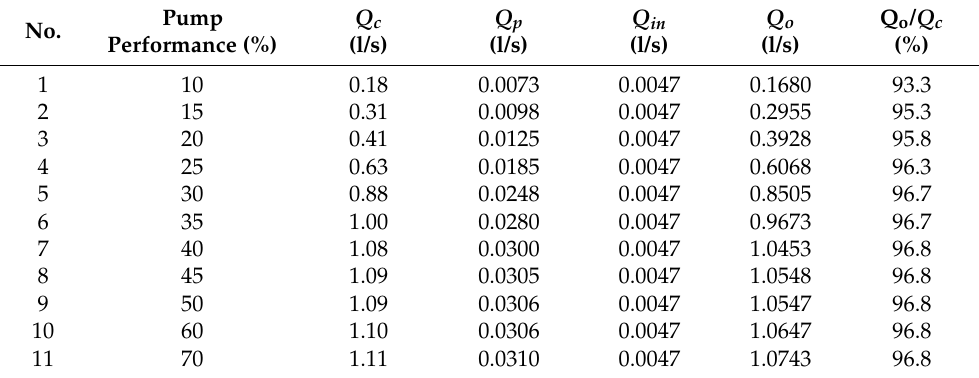
Table 7. Pilot test on the HJ-4 extraction well on 2 July 2020.